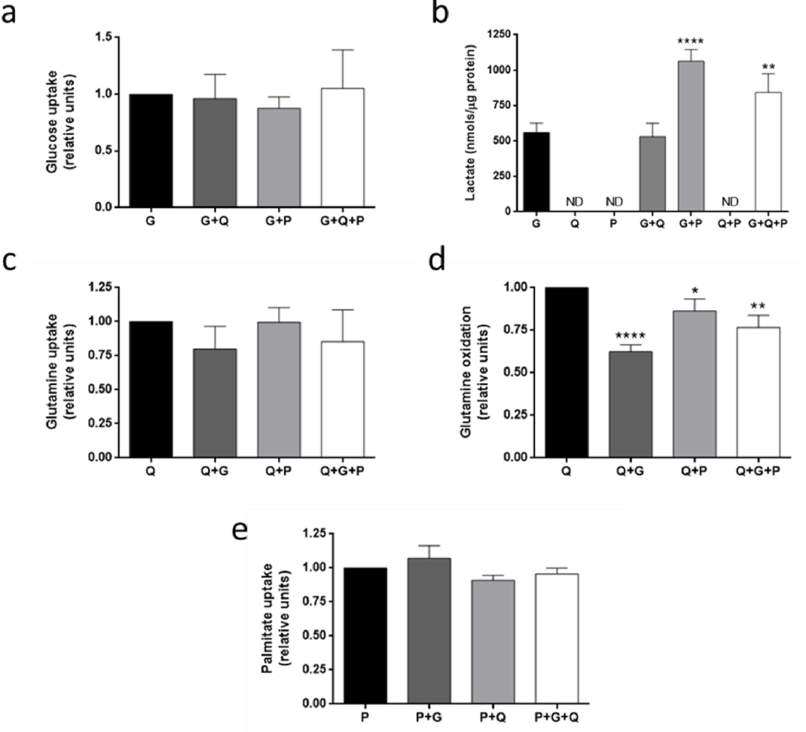
Figure 6. Substrate uptake and utilization in HMEC. ( a ) Glucose uptake, ( b ) lactate production, ( c ) glutamine uptake, ( d ) glutamine oxidation and ( e ) palmitate uptake were determined in HMEC in the presence or absence of 5 mM glucose (G), 0.5 mM glutamine (Q) and / or 0.5 mM palmitate (P). Data are expressed as means ± SD of three independent experiments. * p < 0.05, ** p < 0.01, **** p < 0.0001 versus glucose ( a , b ), glutamine ( c , d ) or palmitate ( e ) conditions. ND: non detected.